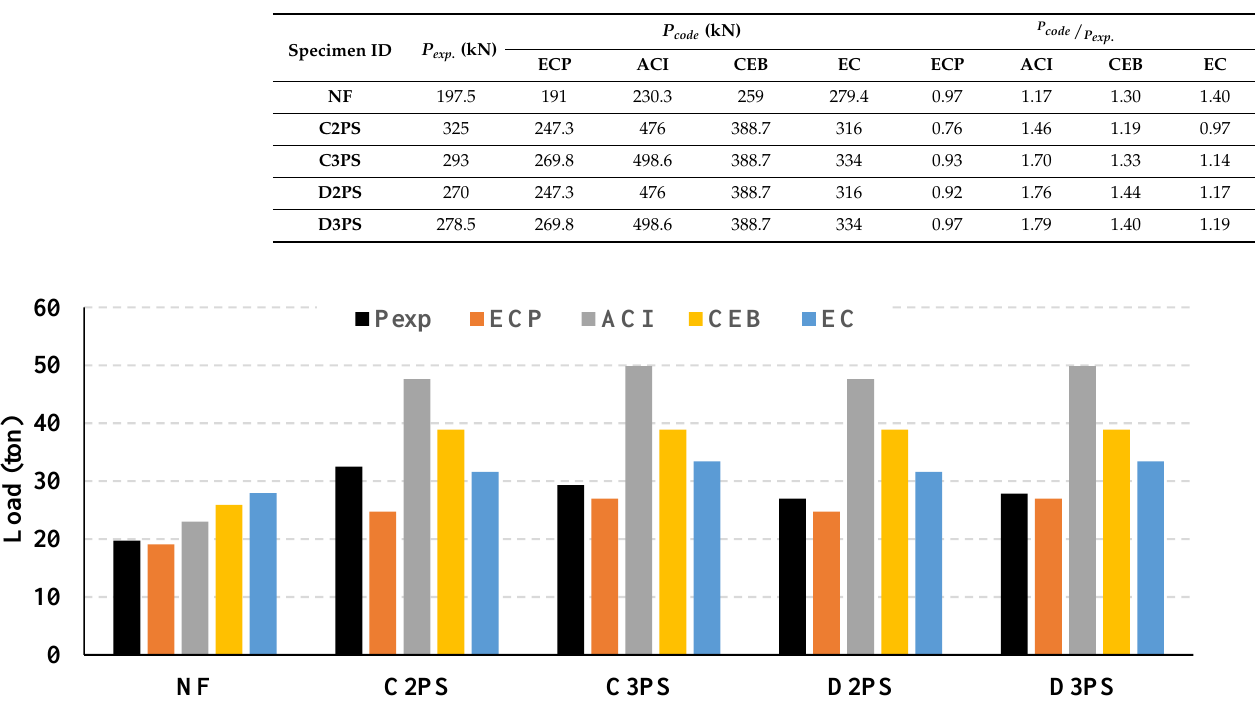
Figure 15. Comparison between codes ultimate punching shear strength of all specimens.